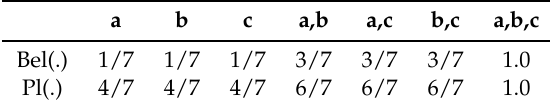
Table 2. Bel and Pl values for Example